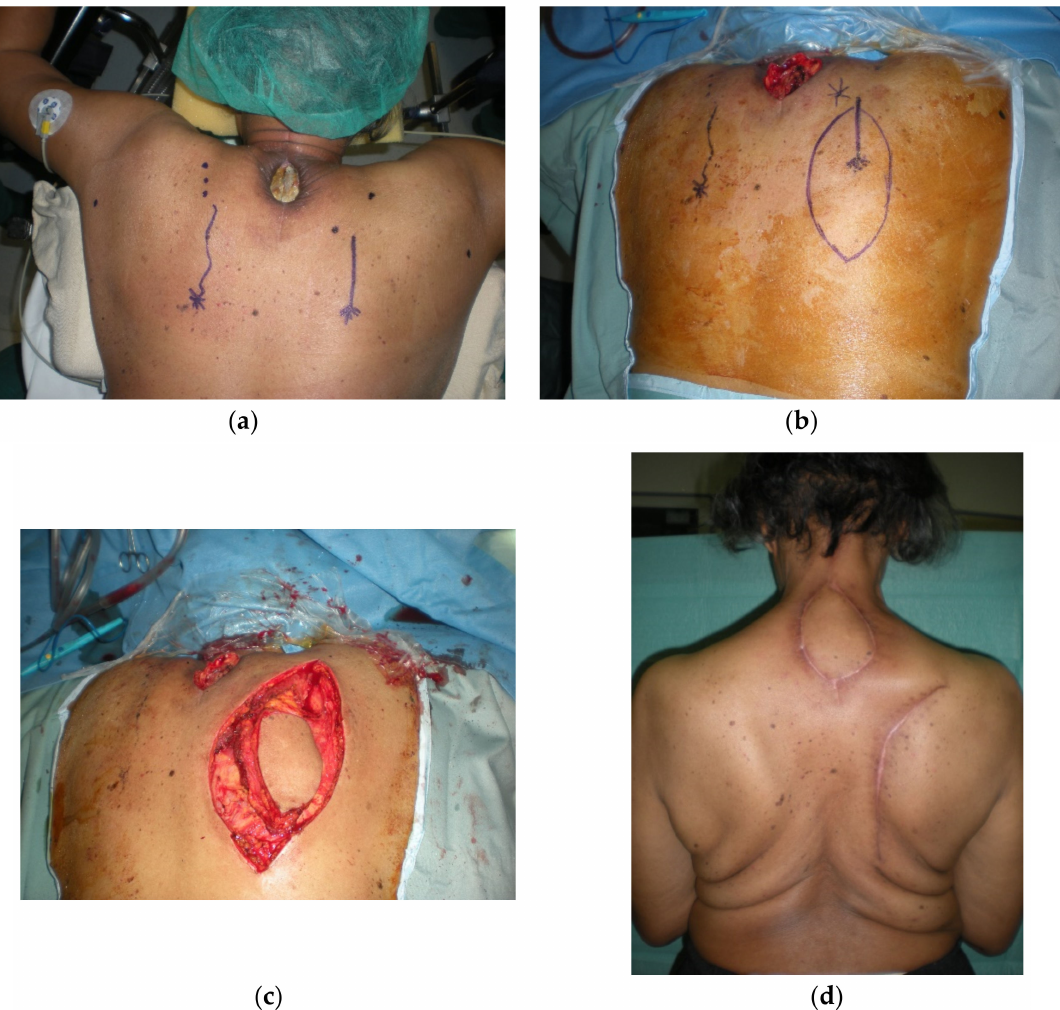
Figure 5. Wound dehiscence after radiotherapy at the cervicodorsal level. Coverage with a perfora‑ tor flap based on the superficial branch of the transverse cervical artery. ( a ) Preoperative image of the defect; ( b ) design of the flap; ( c ) harvested flap; and ( d ) 90 days post‑operative